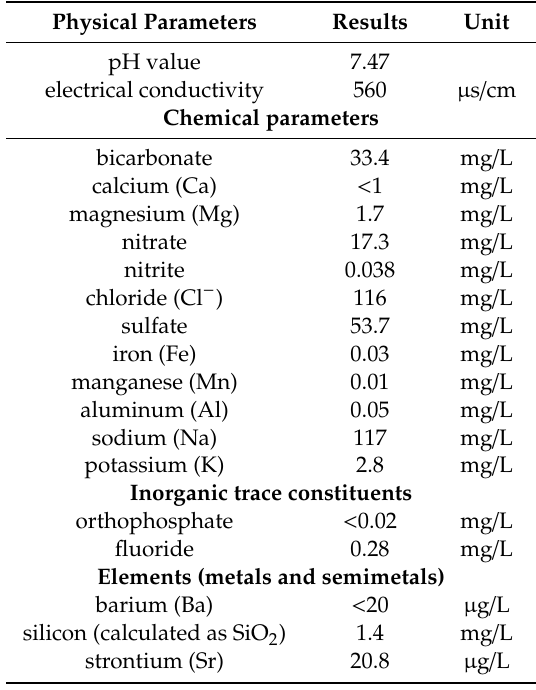
Table 4. Chemical analysis of permeate in the case of pore wetting for synthetic brine feed with